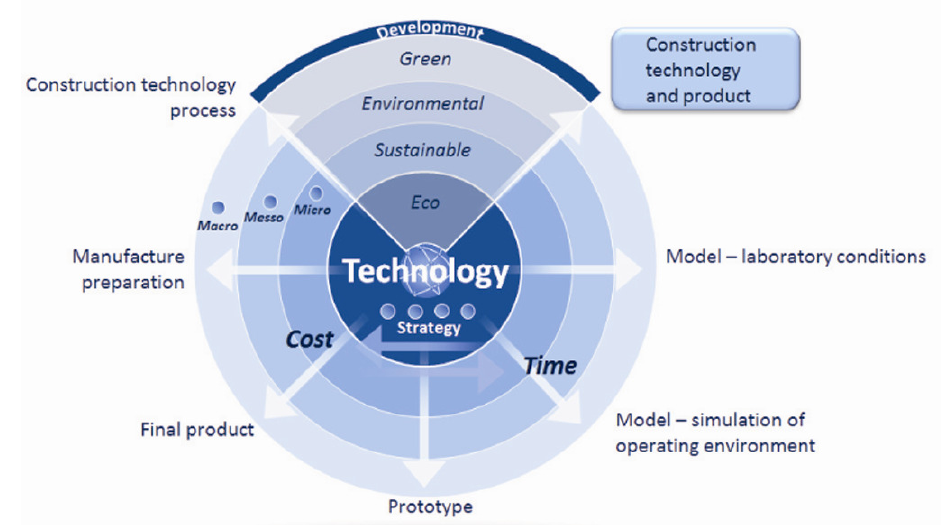
Fig. 1. Advanced technology development